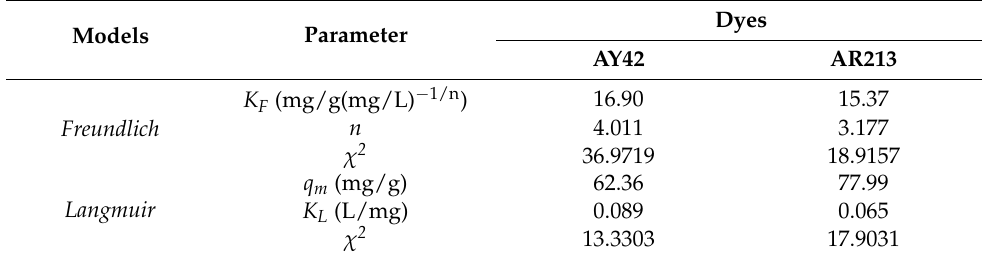
Table 9. Isotherm coefficients for adsorption of AY 24 and AR 213 onto PM4.